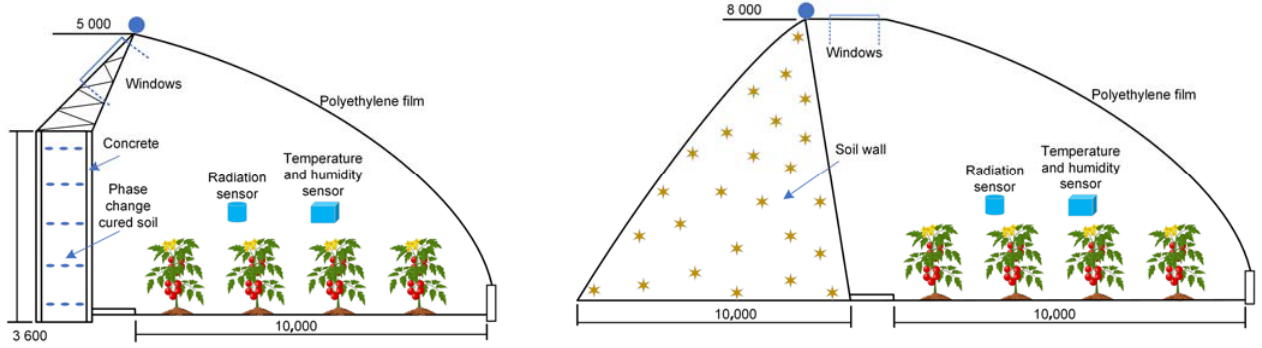
Figure 1. Schematic diagram of experimental solar greenhouses.